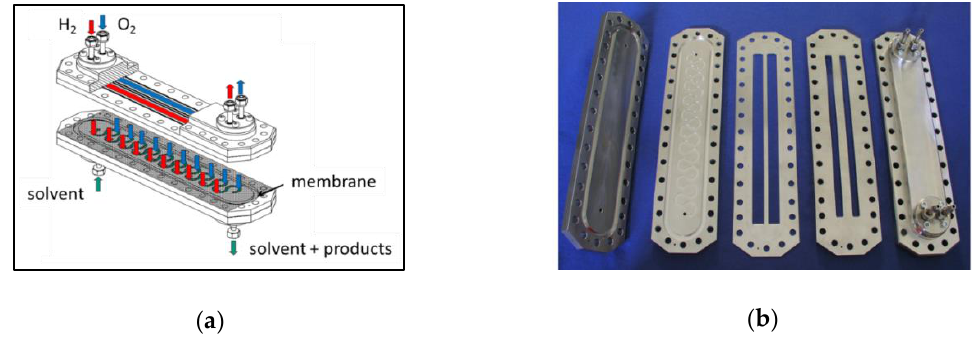
Figure 7. Scheme of the microchannel membrane reactor ( a ) and photo of the plates forming the actual device (from left to right): liquid adapter plate, micro channel plate, membrane frame bottom, membrane frame top including gas chambers and gas adapter plate ( b ). Adapted from Ref. [57].